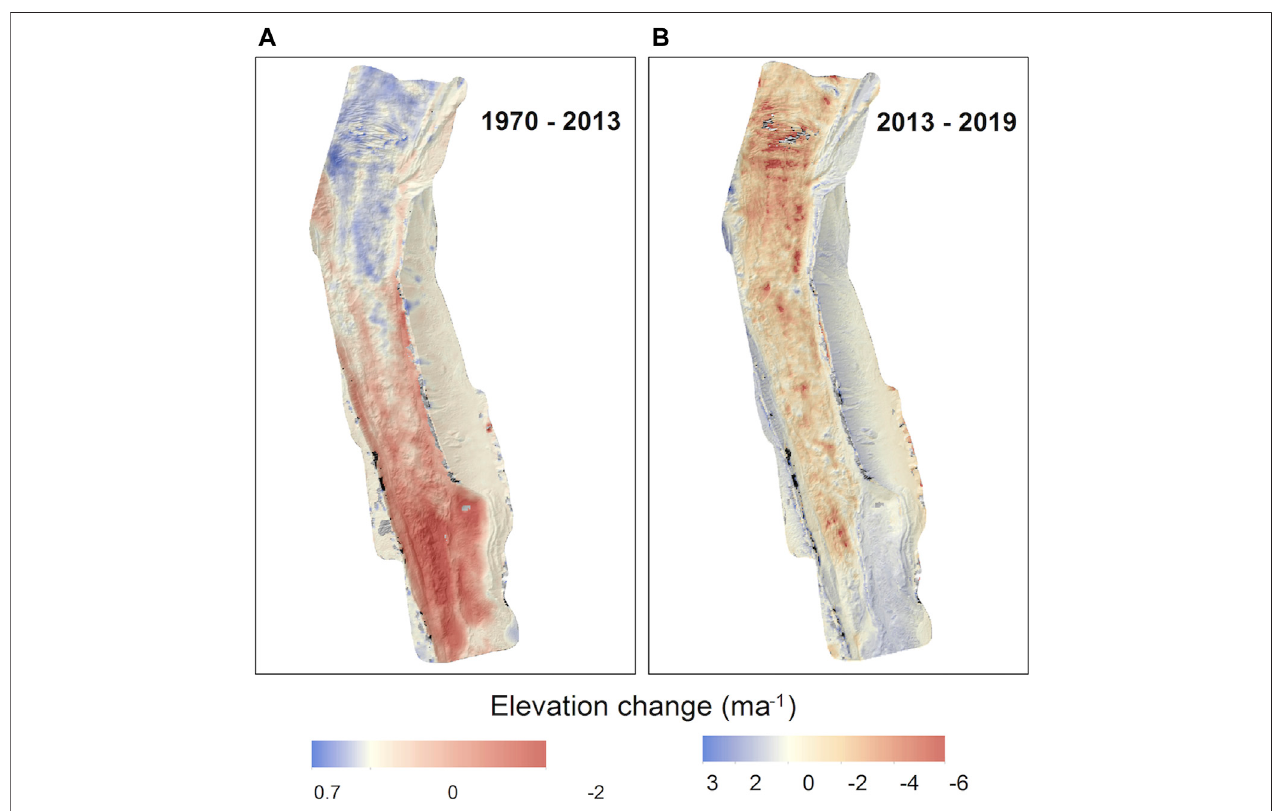
FIGURE 4 | Surface elevation changes on the lower ablation part of Ponkar Glacier from (A) 1970 to 2013 and (B) 2013 to 2019.